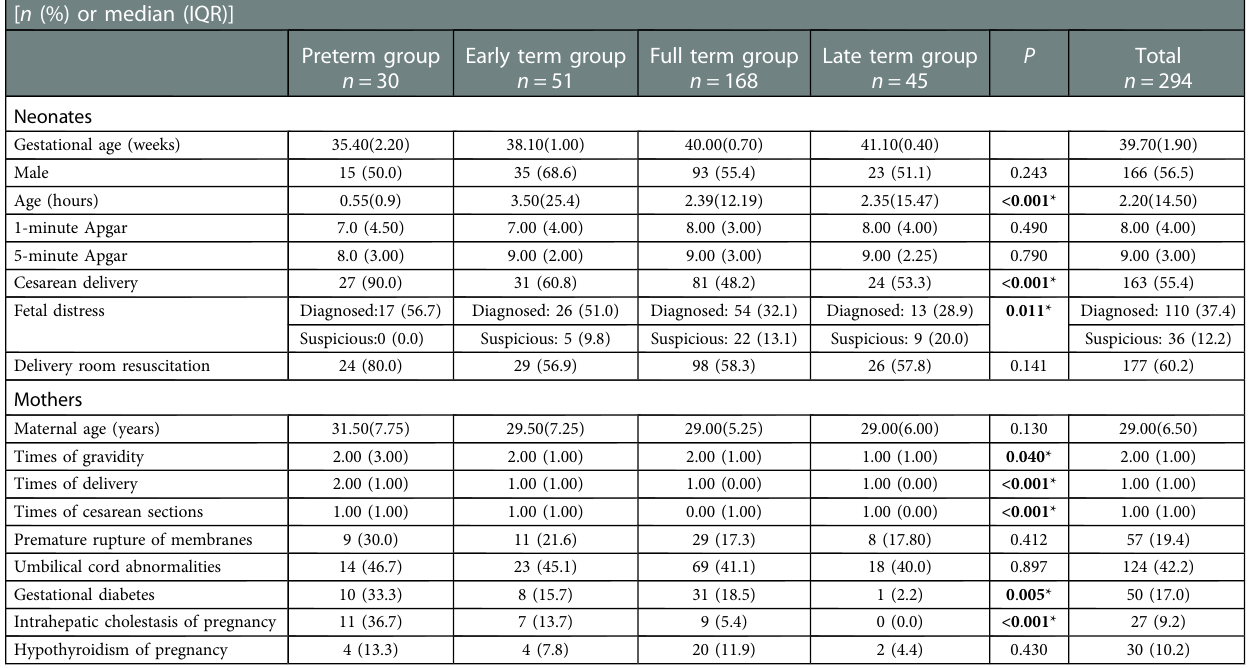
TABLE 2 Comparison of basic demographic and clinical characteristics of patients with different gestational